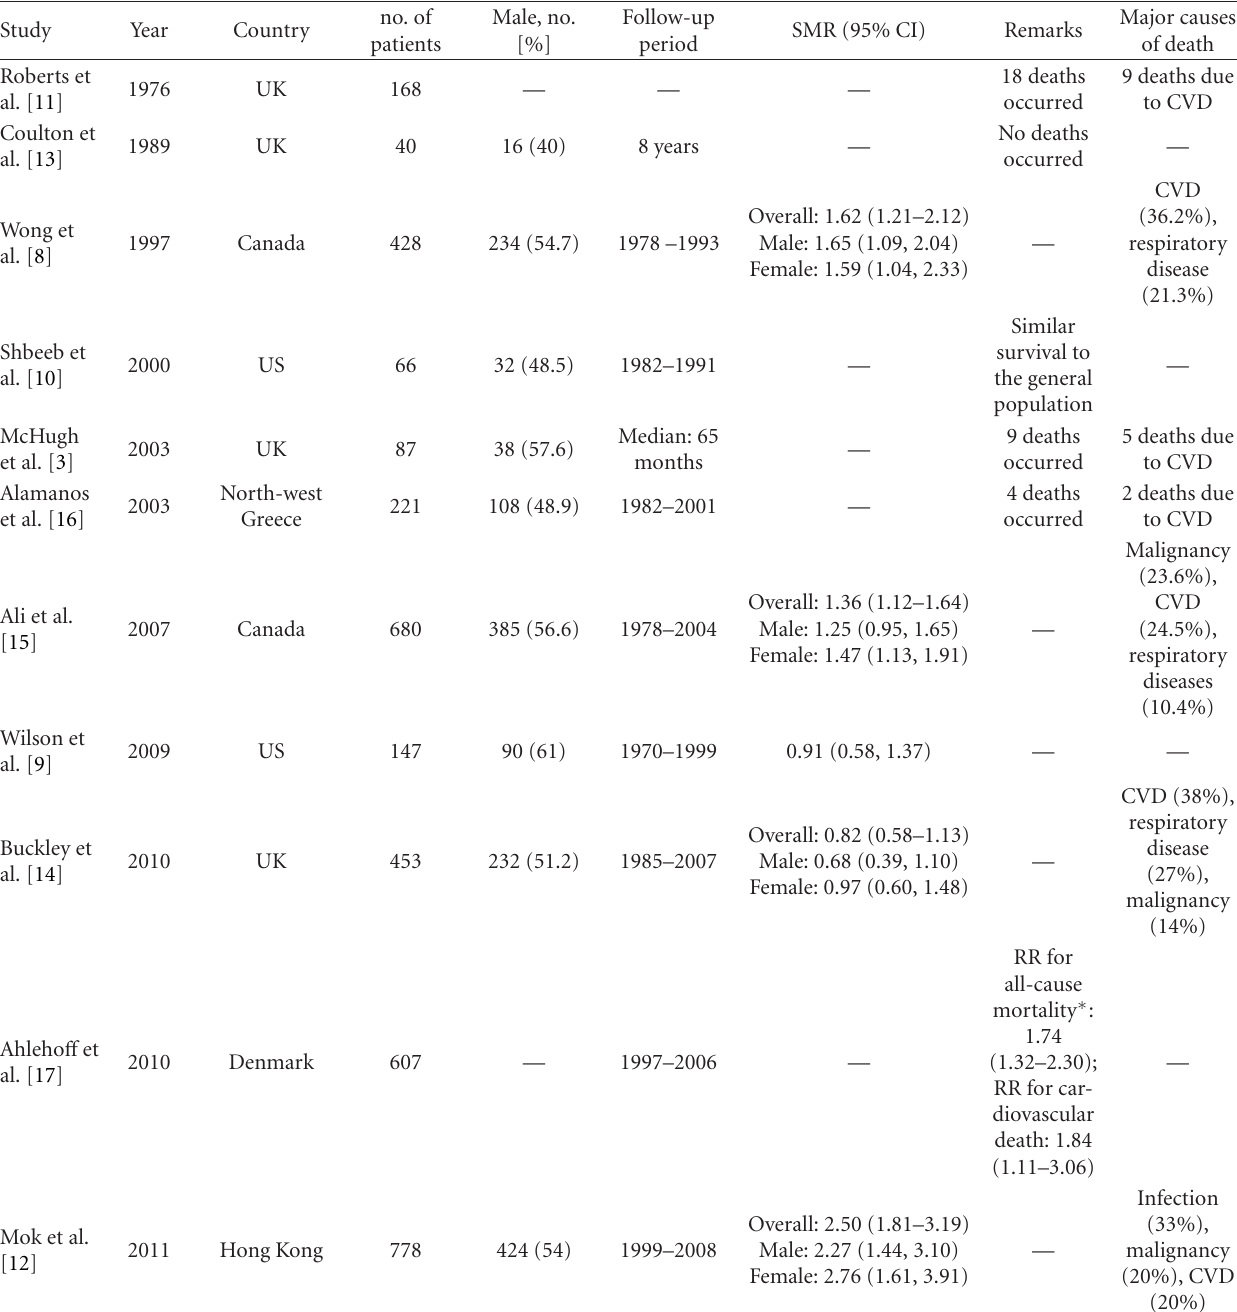
Table 1: Mortality studies in psoriatic